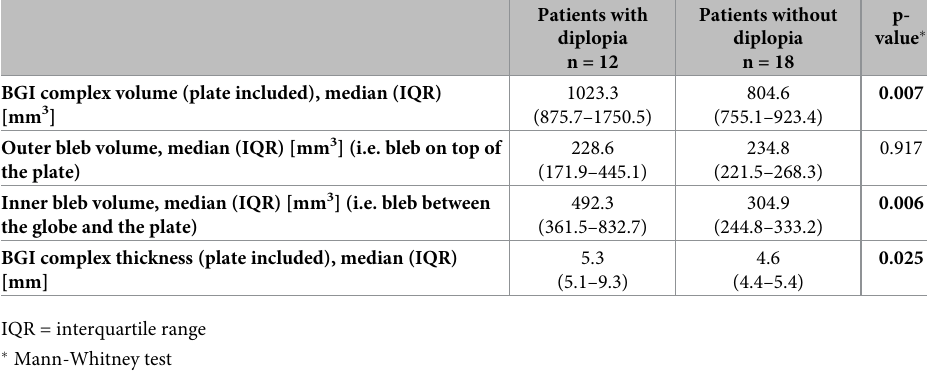
Table 2. Measured bleb sizes for each patient